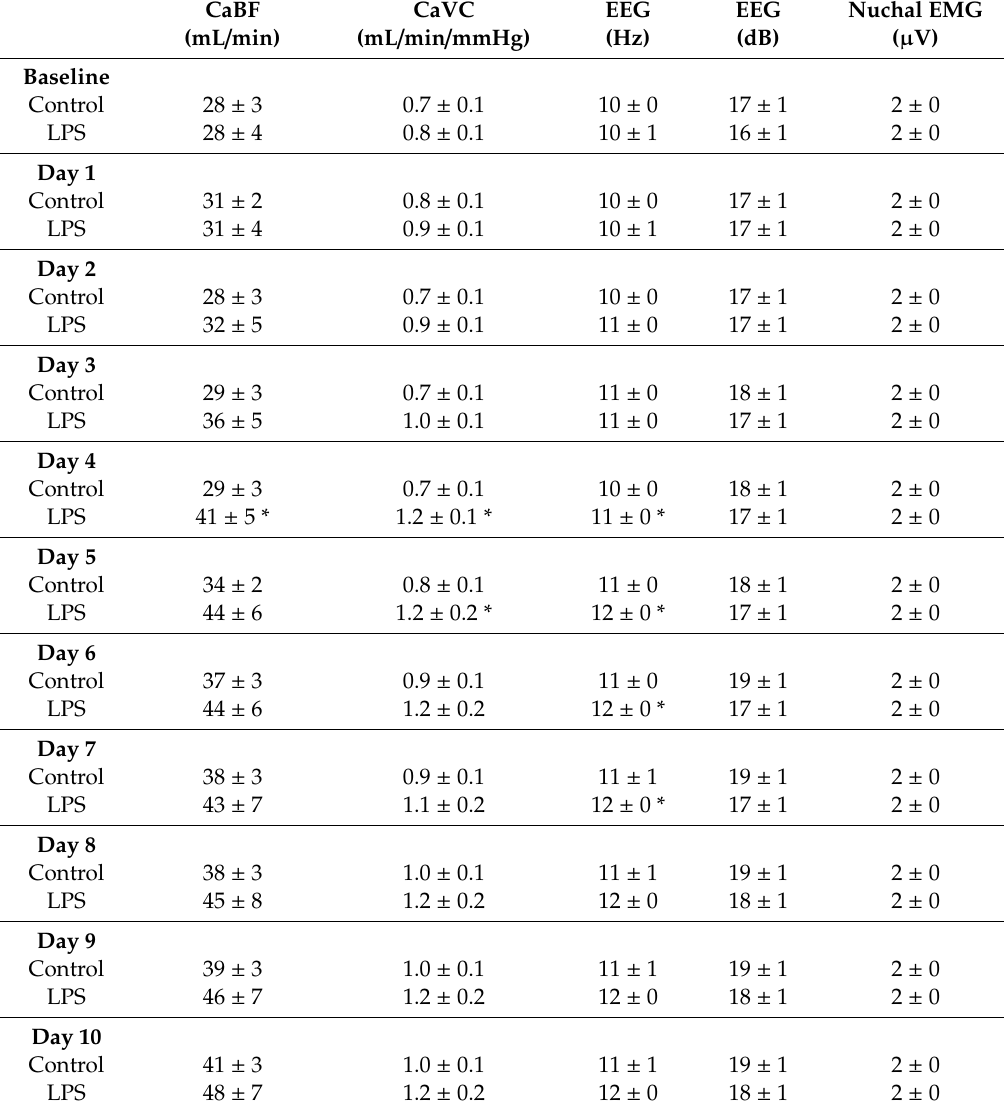
Table 2. Cerebrovascular and neurophysiological changes during fetal inflammation and